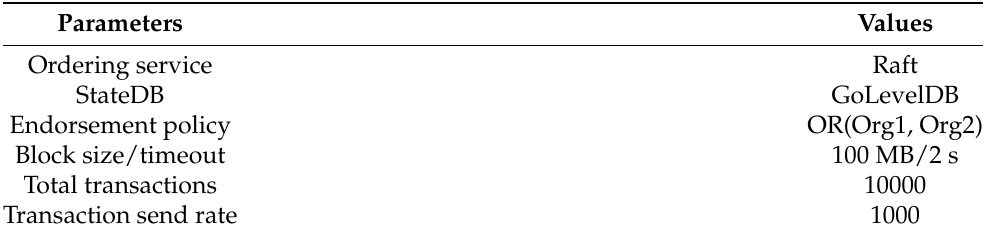
Figure 2. Experimental setup of Fabric components. Table 1. Fabric configuration.